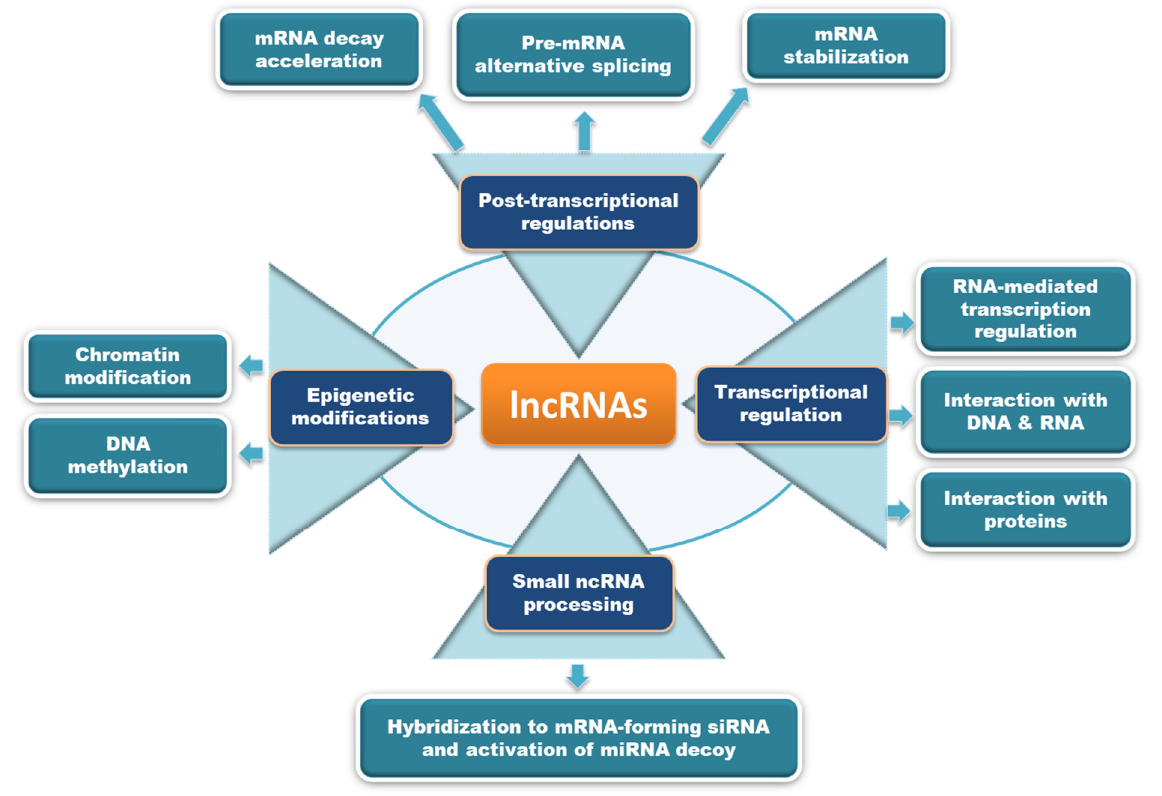
Figure 2. The potential mechanisms of action through which lncRNAs modulate biological functions are depicted here. LncRNAs may act either by processing small ncRNAs, epigenetic modifications, transcriptional regulation, or post-transcriptional modifications to mediate different biological effects.